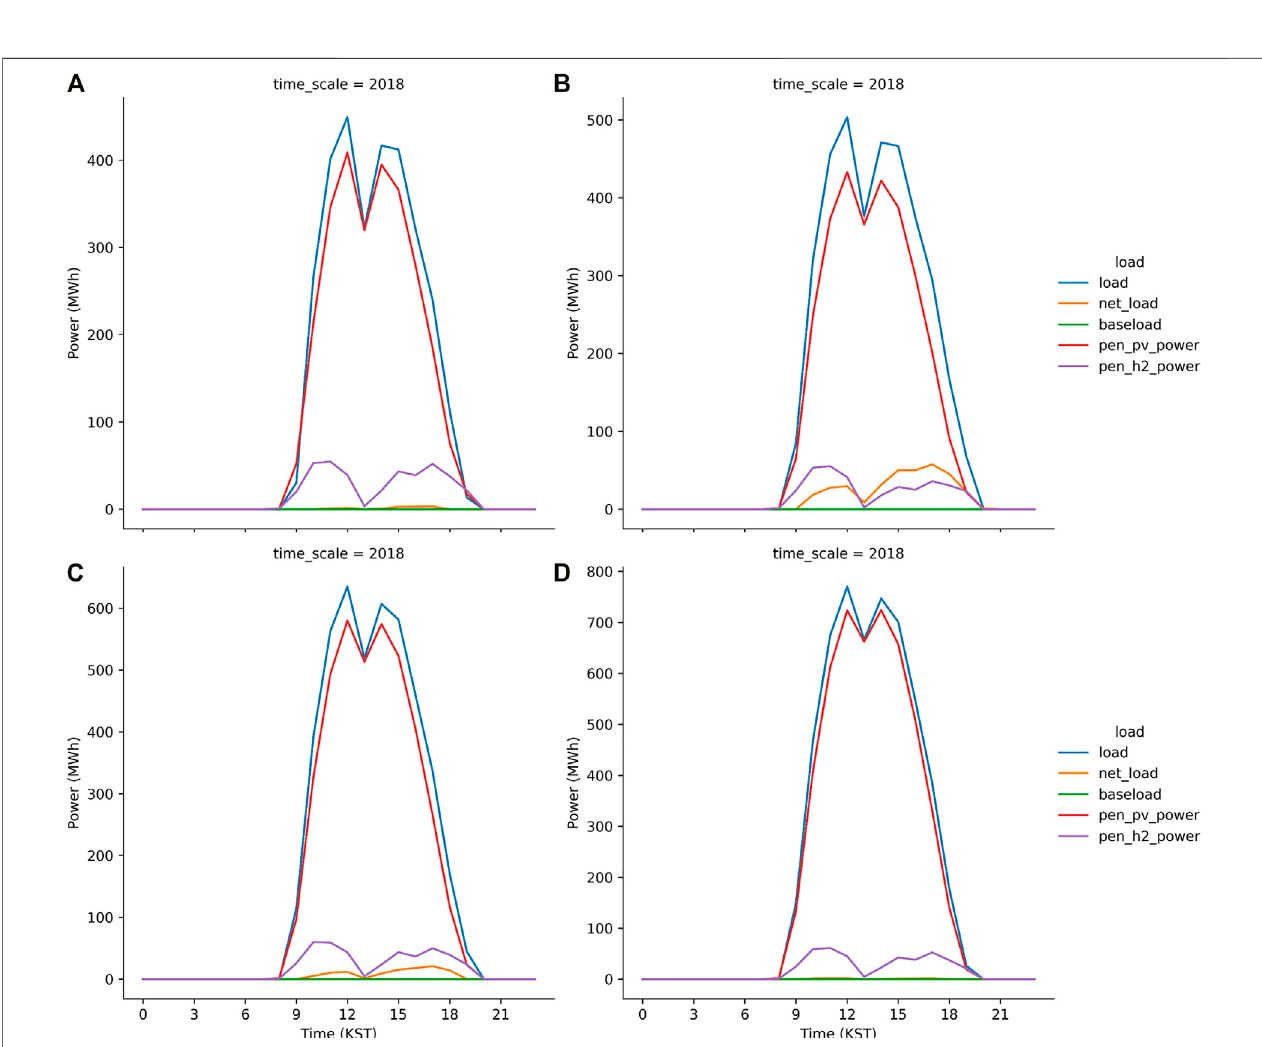
FIGURE 12 | Same as Figure 8 but from S4 run (A) , S5 run (B) , S6 run (C) and S7 run (D) .